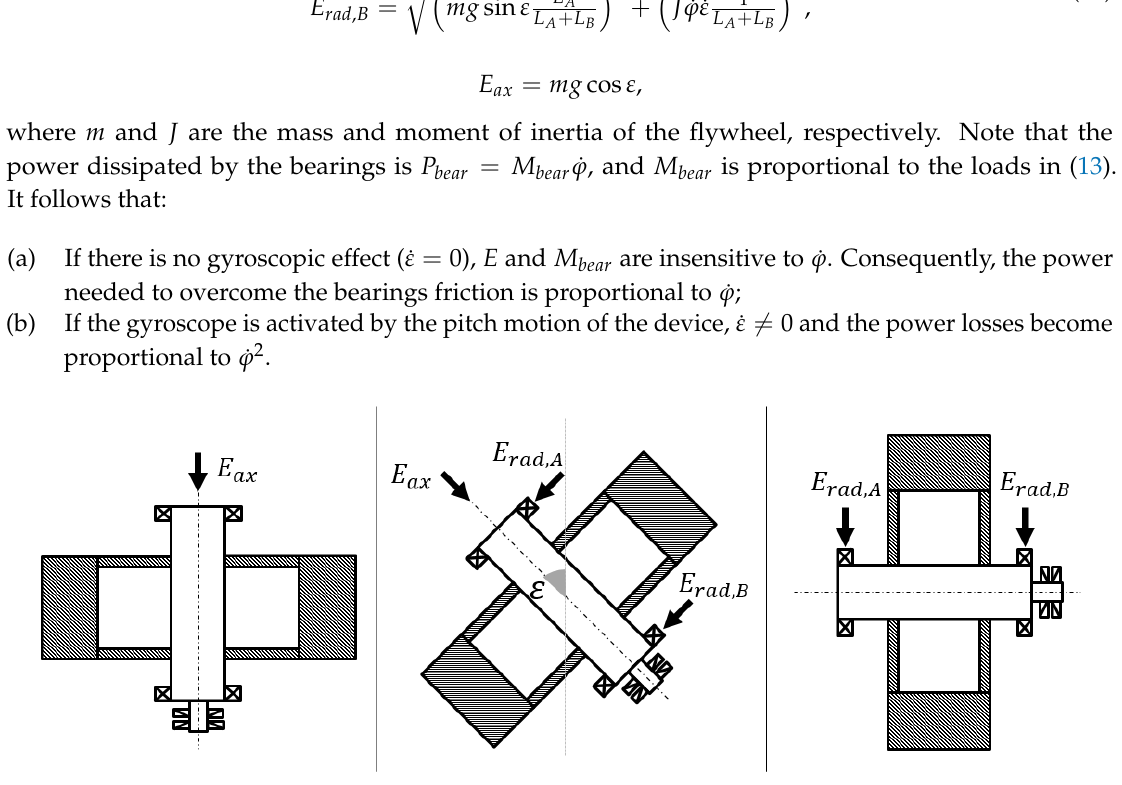
Figure 13. Loading scheme of the bearings for different precession angles, equal to 0, 45 and 90 degrees, from left to right